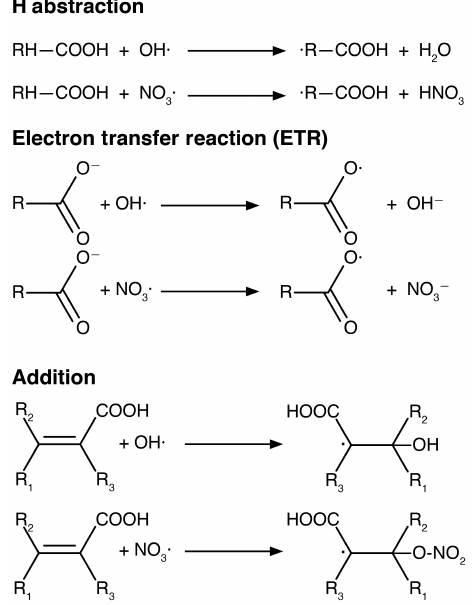
Figure 14. Schematic of the initial reaction steps for the most im- portant radical oxidation pathways of dissociating organic com- pounds (exemplified for carboxylic